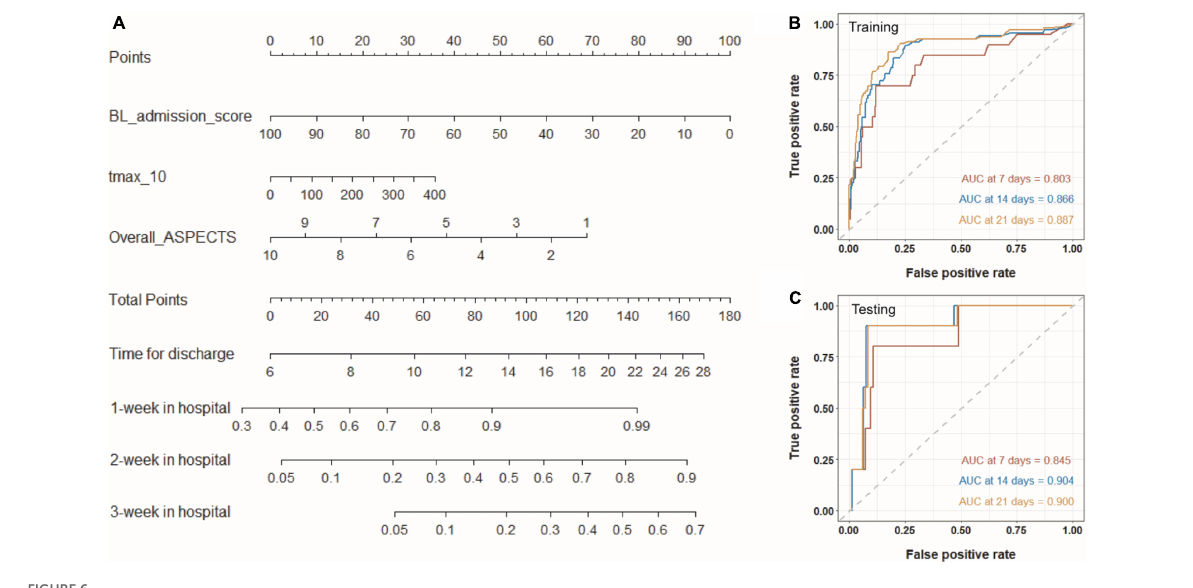
FIGURE6 Nomogram for predicting the time for achieving a good outcome. (A) Three variables from Cox proportional hazard regression model are included into the nomogram model. For a given sample, each variable has a point, and the total point reflected the time for discharge and the probability of the patient staying 1, 2, or 3 weeks in hospital. Panels (B,C) show time-dependent ROC curves of the model for the training and testing